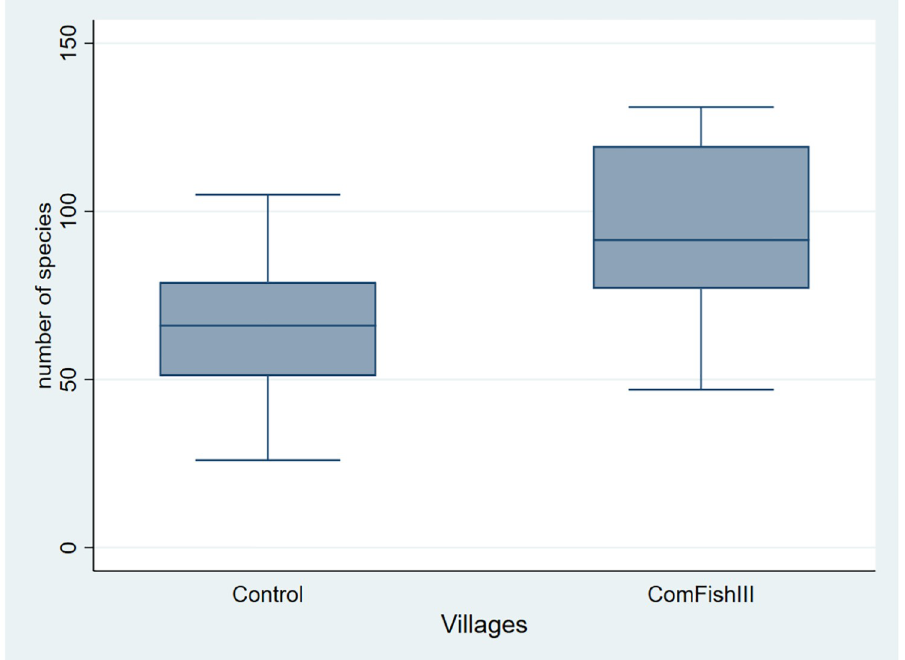
Fig 2. Number of species caught in treated (ComFishIII) and control villages Box plot with extreme values (minimum and maximum) and the three quartiles of distribution of number of species.